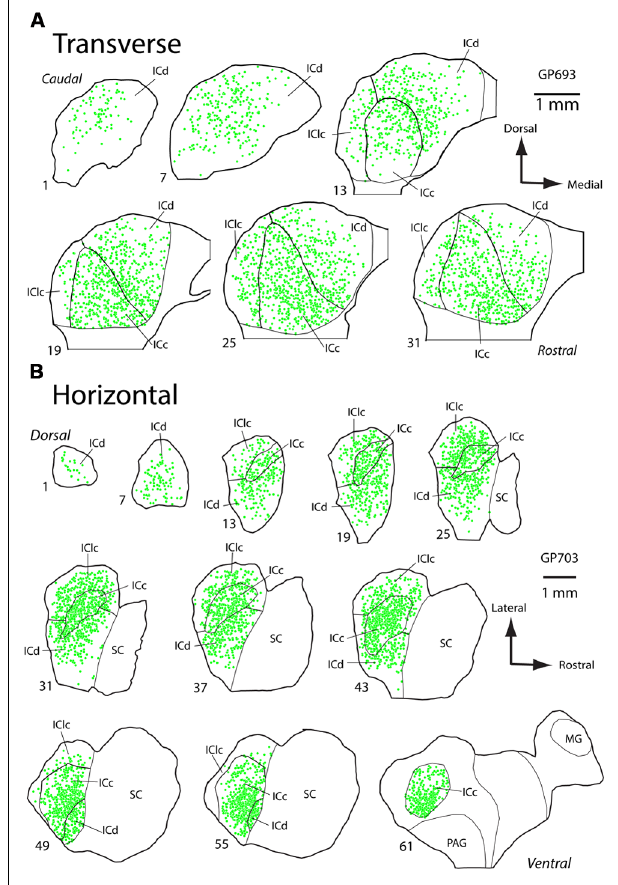
FIGURE 2 | Plots ofWFA-labeled PNs in the inferior colliculus (IC). (A) Plot showing the distribution ofWFA-labeled PNs (green circles) in transverse sections through the IC. Sections progress from caudal to rostral. Medial is right, dorsal is up. Scale bar = 1 mm. Case GP693. (B) Plot showing distribution ofWFA-labeled PNs (green circles) in horizontal sections through the IC. Sections progress from dorsal to ventral. Rostral is right, lateral is up. Scale bar = 1 mm. Case GP703.